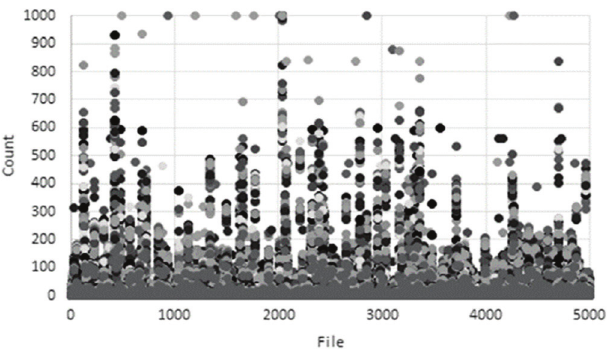
Figure 4. String-based distribution analysis (malware).